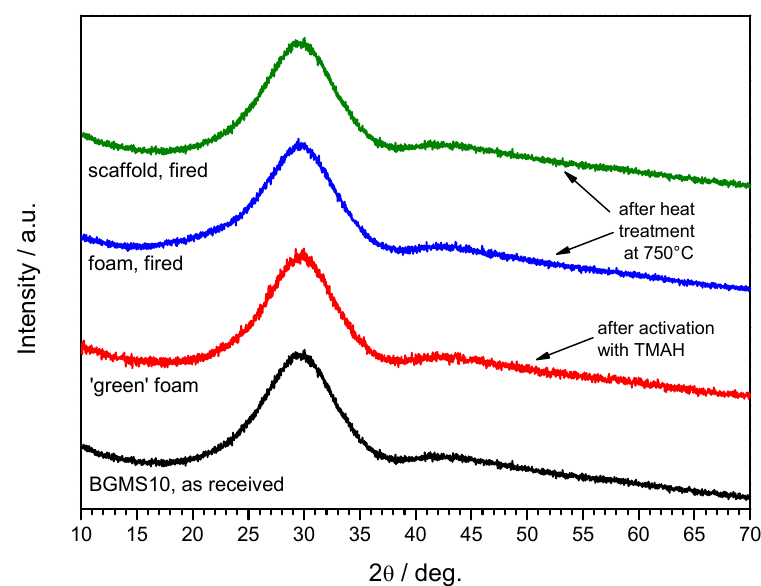
Figure 2. Mineralogical analysis of BGMS10 glass as received, activated with tetramethyl-ammonium hydroxide (TMAH) and after firing at 750 °C (foam and scaffold).